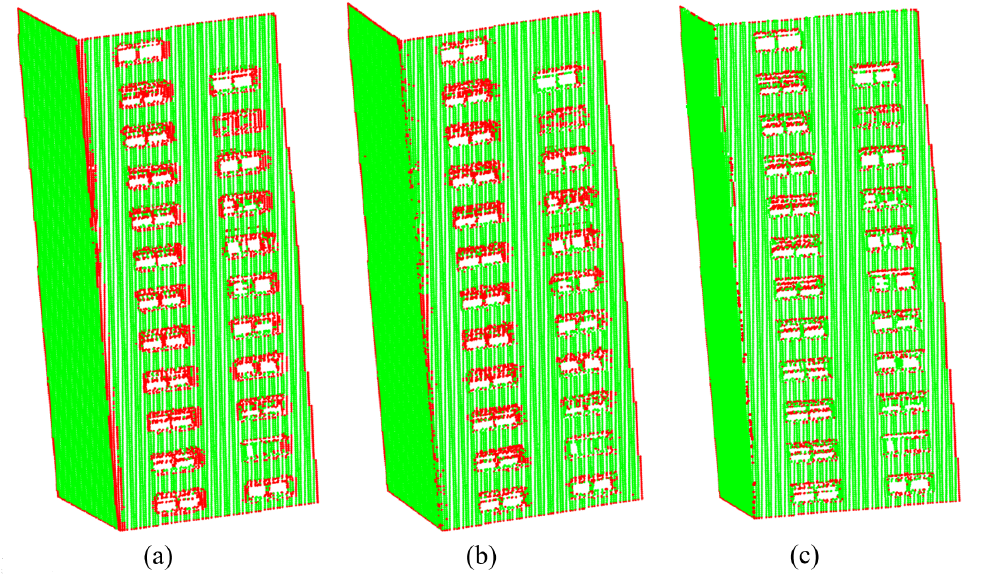
Figure 16. Comparing results on building data by the ( a ) AGPN [16], ( b ) Chen [17], and ( c ) proposed methods. Green indicates the planar points, and red represents both the boundary and the fold edge points.